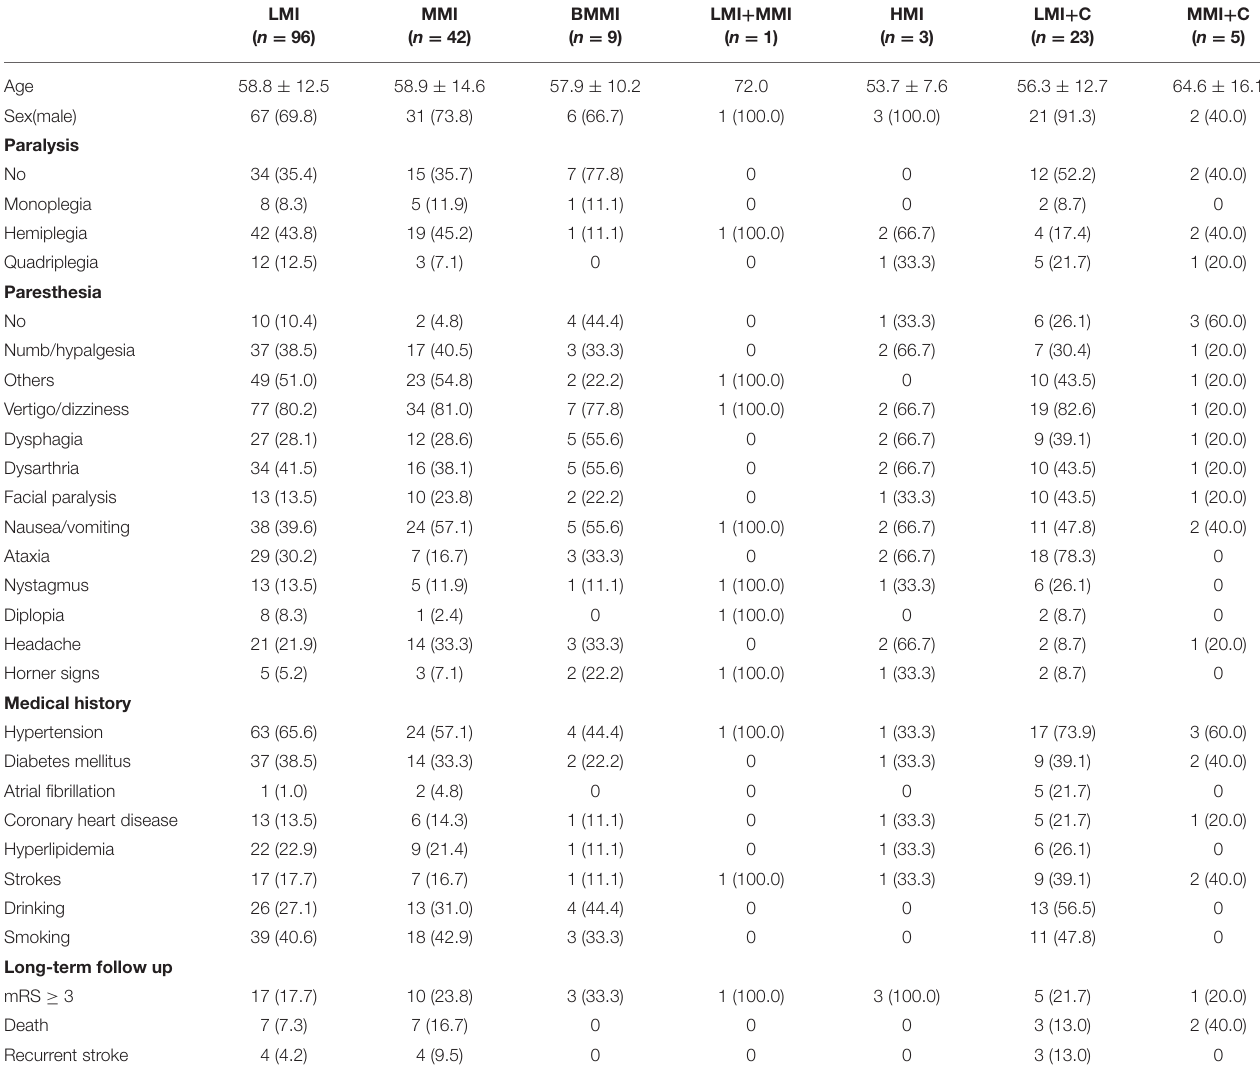
TABLE 1 | Clinical characteristics of 179 patients with medullary